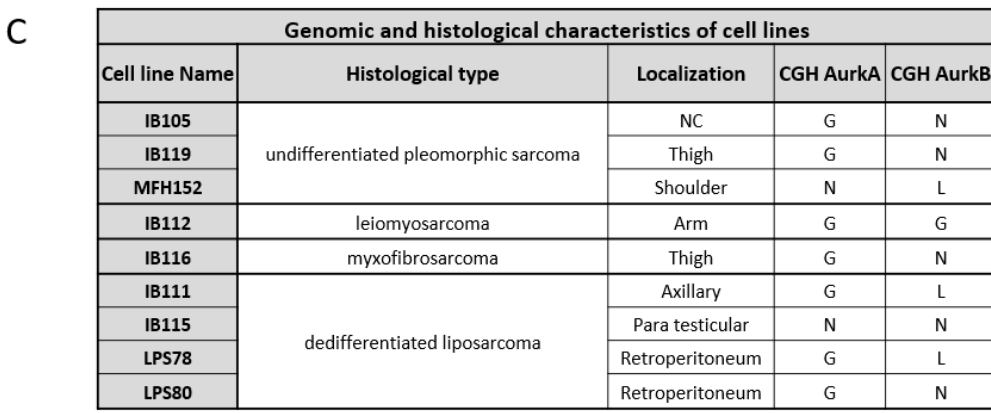
Figure 1. Metastasis-free survival analysis according to mRNAs AURKA and AURKB expression and characteristics of STS cell lines. ( A ) Metastasis-free survival analysis according to mRNA AURKA expression. Subjects are stratified in two groups with significantly different metastasis-free survival rate (MFS rate; y axis) during the time after diagnosis ( x axis). Subjects with the lowest expression compare to mean expression are in red, and those with the highest one are in green. ( B ) Metastasis-free survival analysis according to mRNA AURKB expression. P values correspond to the log-rank test comparing the survival curves. ( C ) Histological type, grade, localization and CGH statute for AURKA and AURKB are listed in the table. G: Gain (2–10 copies of gene present); L: loss (1 copy of gene present); N: no variation (2 copies of gene present). NC: not communicated.